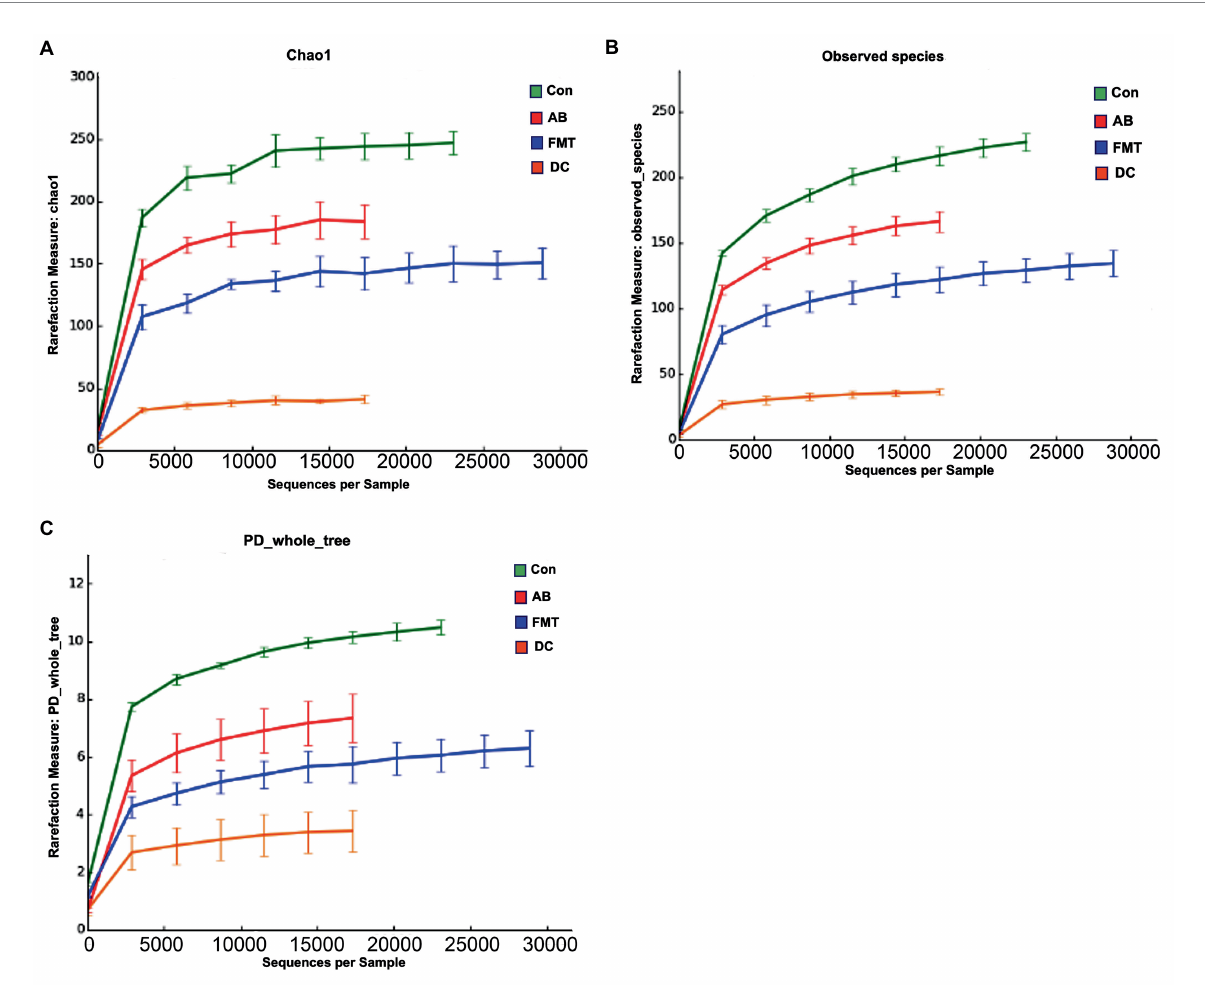
FIGURE 2 The species rarefaction curve of each experimental group. This graph represents the numbers of observed species under different sequences numbers extracted randomly, Chao 1 (A) , Observed species (B) , and PD whole tree (C) . Chao 1, Chao’s estimated richness; PD, Phylogenetic distance; Con, Control group; FMT, fecal microbiota transplantation group; AB, antibiotic group; DC, donor